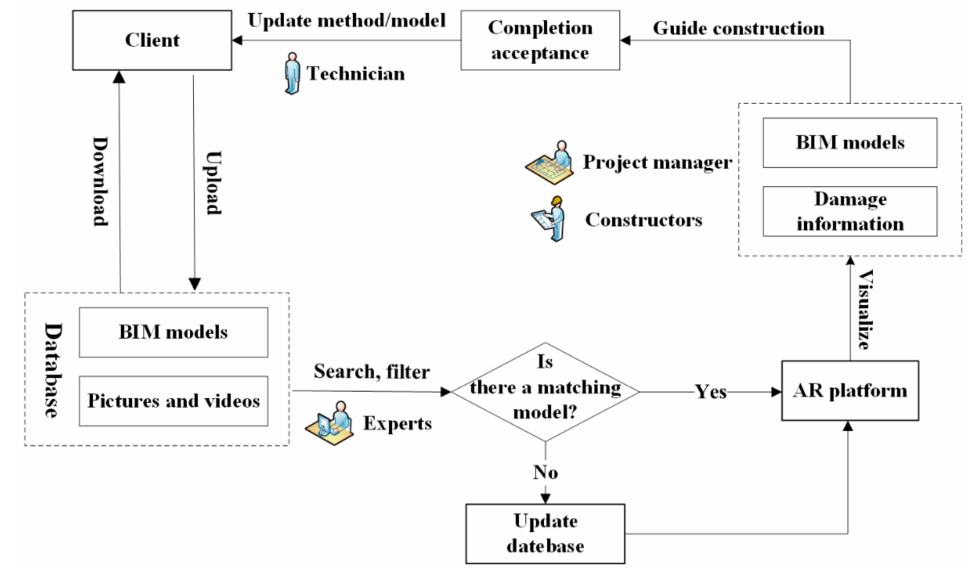
Figure 2. Visualization process of post-earthquake retrofitting of